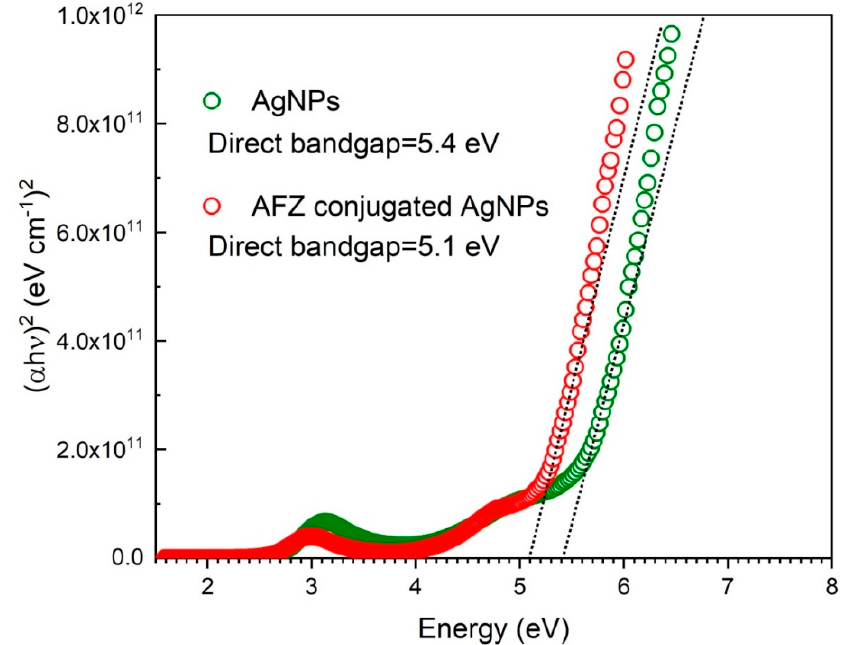
Figure 3. Calculation of the bandgap energies from absorption spectra of the bare AgNPs and afzelechin conjugated AgNPs.